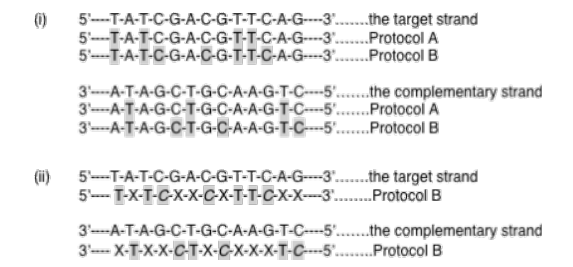
Figure 1: Strategy for sequencing DNA using the osmylated strands. All sequences shown refer to deoxybases; for simplicity d is left out. (i) Original proposed route for obtaining the sequence of the target strand by osmylating both the target strand and its complementary with Protocols A and B [46]; Protocol A yields primarily osmylated-T (shaded) and Protocol B yields practically 100% osmylated pyrim- idines (shaded T and C). Sequencing the complementary strand provides indirectly information on A and G. This approach presumes discrimination between osmylated from intact base, but no discrimina- tion among pyrimidines. (ii) The data presented in this report strongly suggest that α -HL discriminates osmylated-T (shaded regular font) from osmylated-C (shaded italic font) and intact purine (X). Therefore a streamlined strategy might be to sequence osmylated strands using only one protocol, perhaps Protocol B. For further discussion on the sequencing strategy